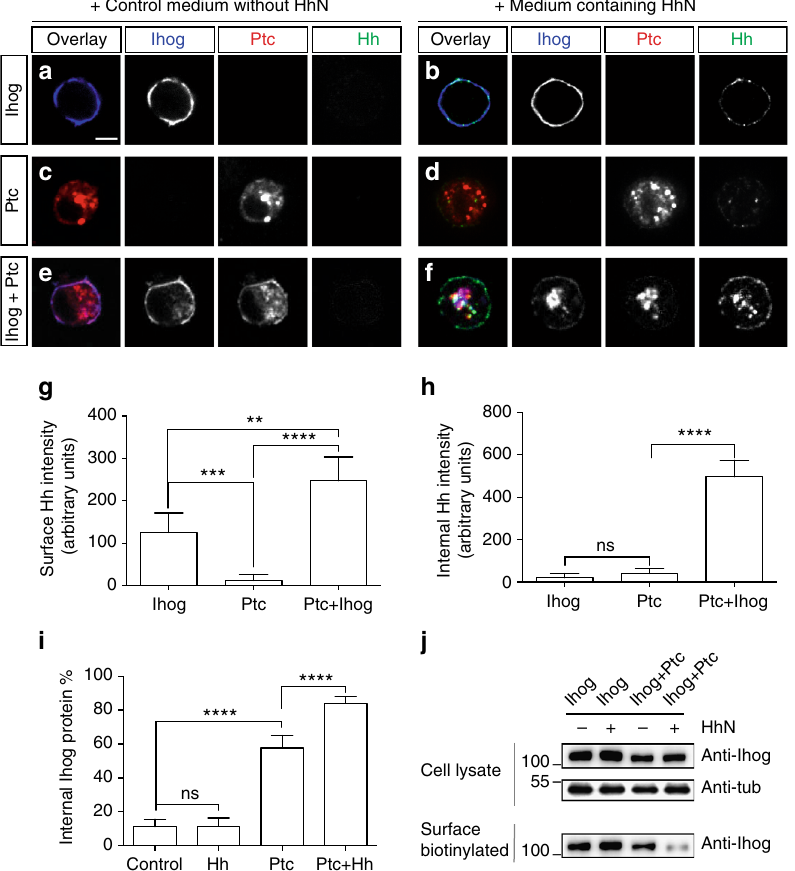
Fig. 1 Subcellular localization of Ihog, Ptc and Hh in S2R+ cells. a – f Confocal microscope images showing localization of HhN (green), Ihog (blue), and Ptc (red) proteins. Drosophila S2R+ cells were transfected for expression of Ptc and/or Ihog, followed by treatment of control medium without Hh ( a , c , e ) or medium containing HhN ( b , d , f ) for 1 h at room temperature. Scale bar, 5 µ m. g , h Quanti fi cation of surface HhN intensity ( g ) and internalized HhN intensity ( h ) from cells transfected with Ptc and/or Ihog. Each bar shows the mean ± s.d. of fl uorescence from n = 20 cells, and representative images are shown in b , d , f . i Quanti fi cation of Ihog protein intensity both on the cell surface and inside of the cells. Internal Ihog protein% = Ihog internal intensity/ (Ihog internal intensity + Ihog surface intensity)%. Each bar shows the mean ± s.d. from n = 20 cells, and representative images are shown in a , b , e , f . Two-tailed unpaired Mann – Whitney U -test was used for statistical analysis. ns not signi fi cant. ** P < 0.01. *** P < 0.001. **** P < 0.0001. j S2R+ cells transfected for expression of Ptc and/or Ihog were labeled by surface biotinylation. Immunoblots in the top panels show 5% of the biotinylated cell lysate, and the bottom panel shows the biotin-labeled proteins recovered by Streptavidin agarose beads. Co-expression with Ptc and treatment of HhN